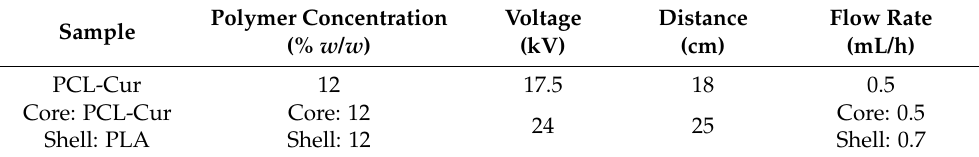
Voltage Distance Flow Rate (kV) (cm) (mL/h) Core: 0.5 24 25 Shell: